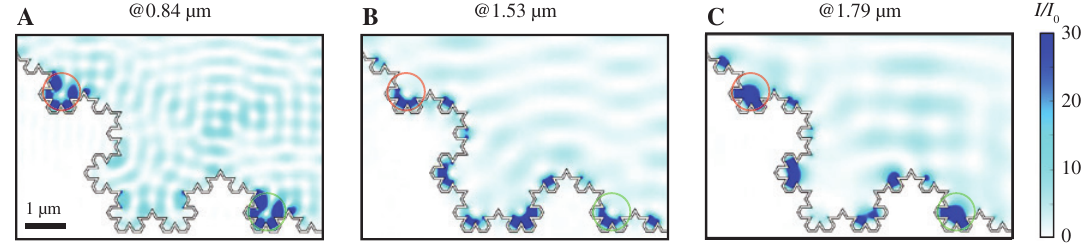
Figure 4: Localising photons with different wavelengths in the same region. Plasmonic leaf K4 with strong localisation of light for (A) λ = 0.84 μ m, (B) λ = 1.53 μ m, and (C) λ = 1.79 μ m. The light at different wavelengths can be localised to the same region, as marked by the red/green